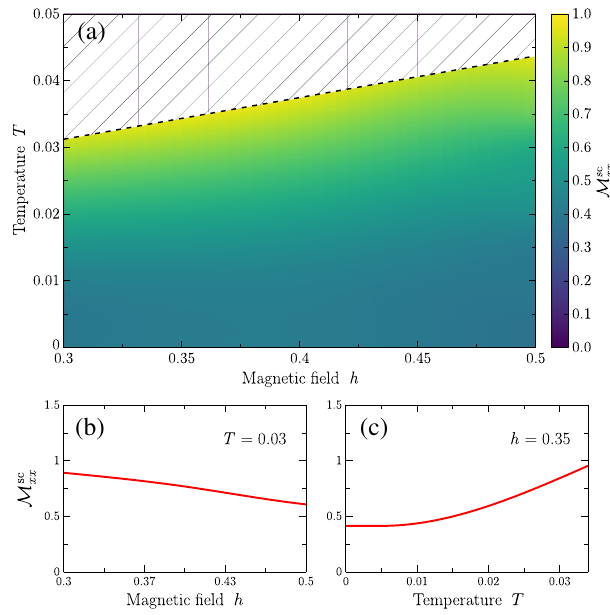
FIG. 9. (a) The colored surface represents the Skyrmion mass M sc in the quantum regime calculated from Eq. (31) for κ ¼ 0 . 1 , xx S ¼ 1 , and ~ J= ~ D ¼ 4 as a function of dimensionless magnetic field h and temperature T (for units, see text). The dashed line T ¼ 2 ð κ þ h= 2 Þ = ð S ð ~ J= ~ D Þ 2 Þ indicates the range of validity of Eq. (31). (b) Magnetic field dependence of M sc temperature T ¼ 0 . 03 and (c) temperature dependence of M sc for a fixed magnetic field h ¼ 0 . 35